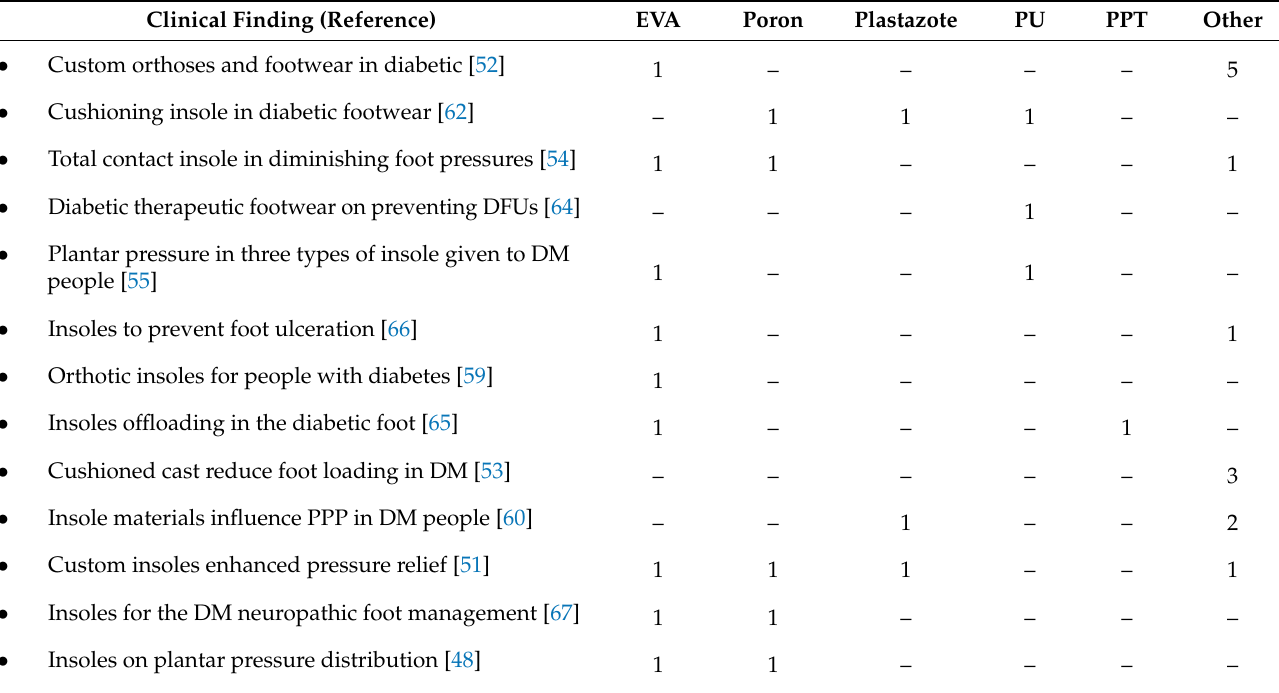
Table 4. The published paper discussed selected insole materials on the rearfoot